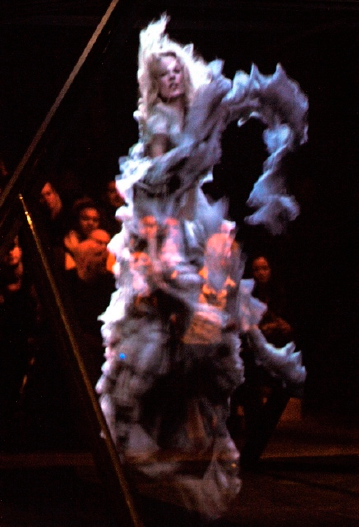
Figure 7. “Holographic” (actually Pepper’s Ghost) model in 2006 Alexander McQueen show. (Photo ©FirstVIEW/IMAXtree.com, used with permission.)